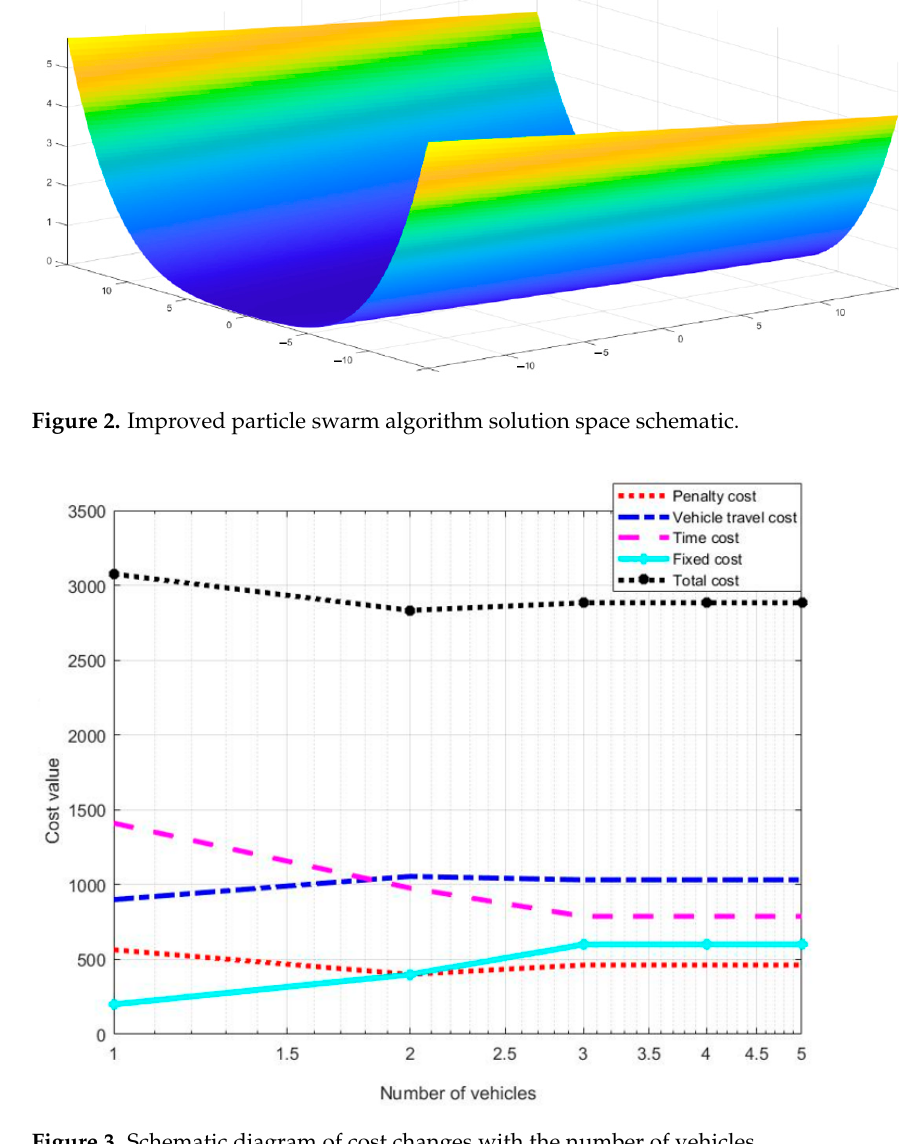
Figure 3. Schematic diagram of cost changes with the number of vehicles.